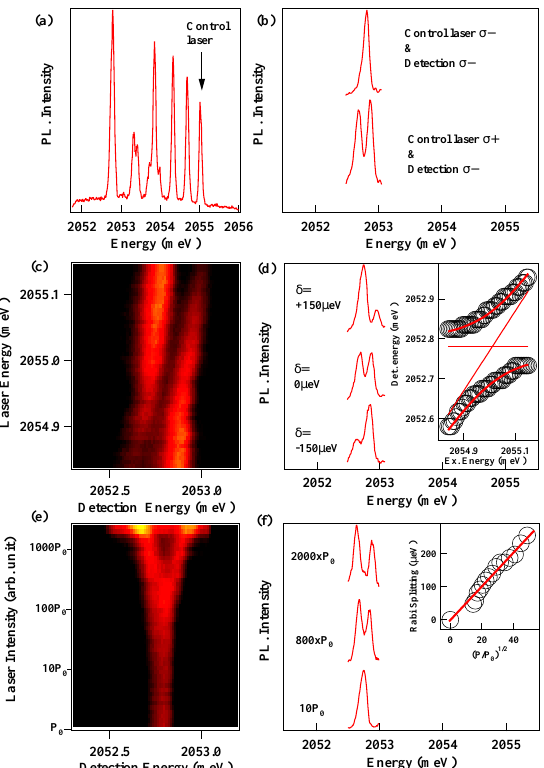
Figure 5: Autler–Townes splitting of the emission of | − 1, +5/2 ⟩ in a Mn-doped QD resonantly excited on | + 1, +5/2 ⟩ . (a) shows the non- resonant PL of the QD. (b) presents the circular polarization depen- dence of the Rabi splitting obtained under resonant excitation. The intensity map (c) shows the excitation energy dependence of the Rabi splitting. The corresponding emission line-shape is presented in (d). The inset shows the spectral position of the Autler–Townes doublet as a function of the pump detuning. The fit is obtained with a Rabi energies (cid:126) Ω r = 180 µ eV. The straight lines correspond to the uncoupled exciton and laser energies. The excitation intensity de- pendence of the Autler-Townes doublet is presented in the intensity map (e). The corresponding emission line-shape are presented in (f). The inset shows the evolution of the Rabi splitting as a function of the square-root of the pump